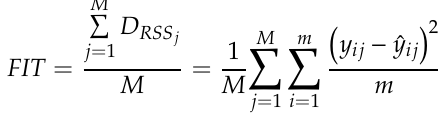
Figure 2. The adjacent day’s Pearson coefficient.